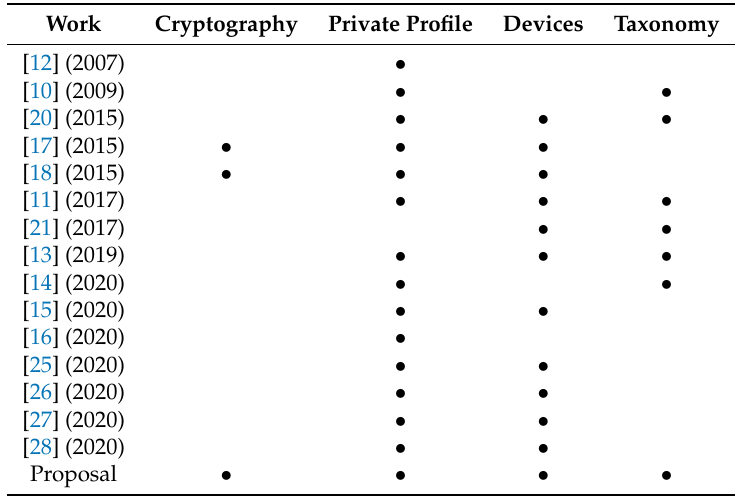
Table 1. Scope of related